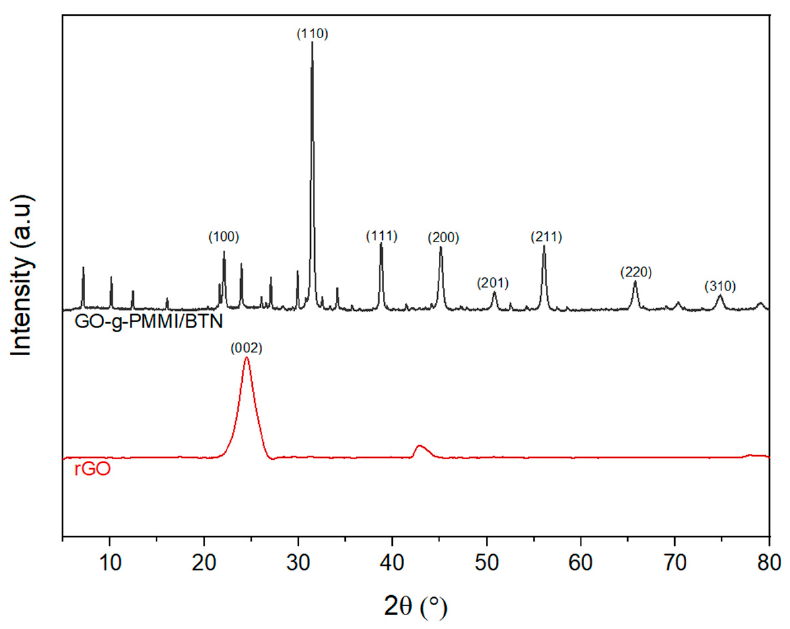
Figure 4. X-ray diffraction patterns of rGO and GO-g-PMMI/BTN.